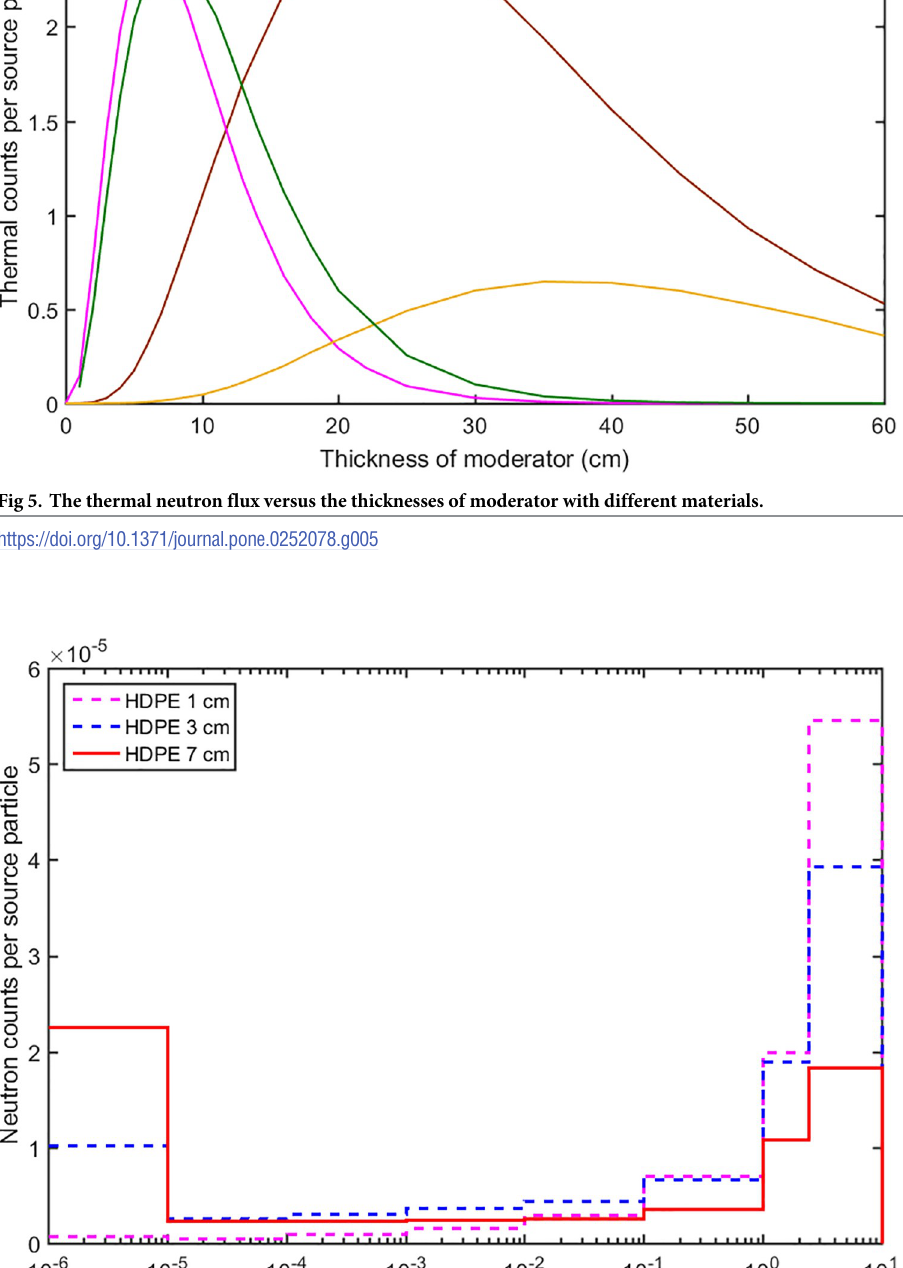
PLOS ONE | https://doi.org/10.1371/journal.pone.0252078 June 14,